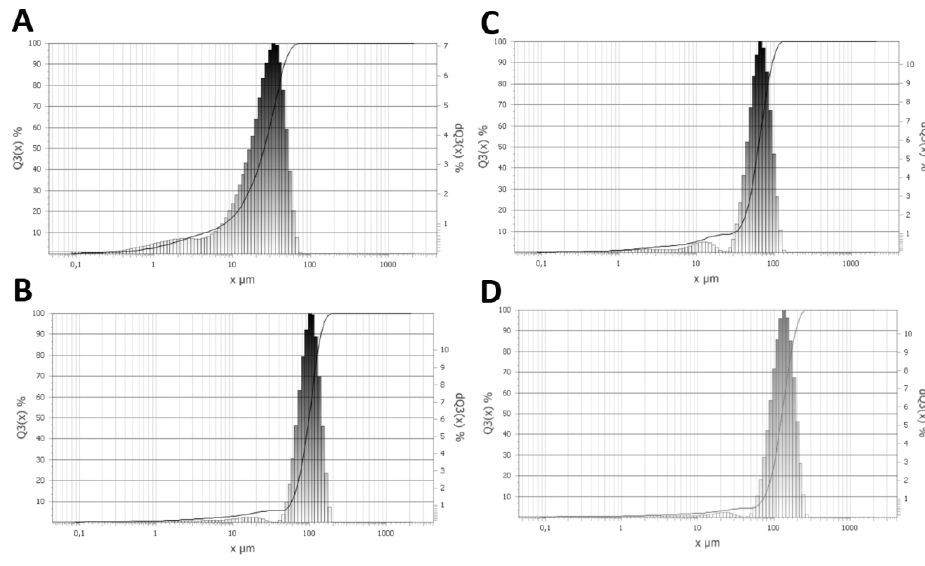
Figure 8. PSD results for raw CSs: ( A ) F_45, ( B ) CS—F_150, ( C ) CS—F _90, ( D ) CS—F_212.